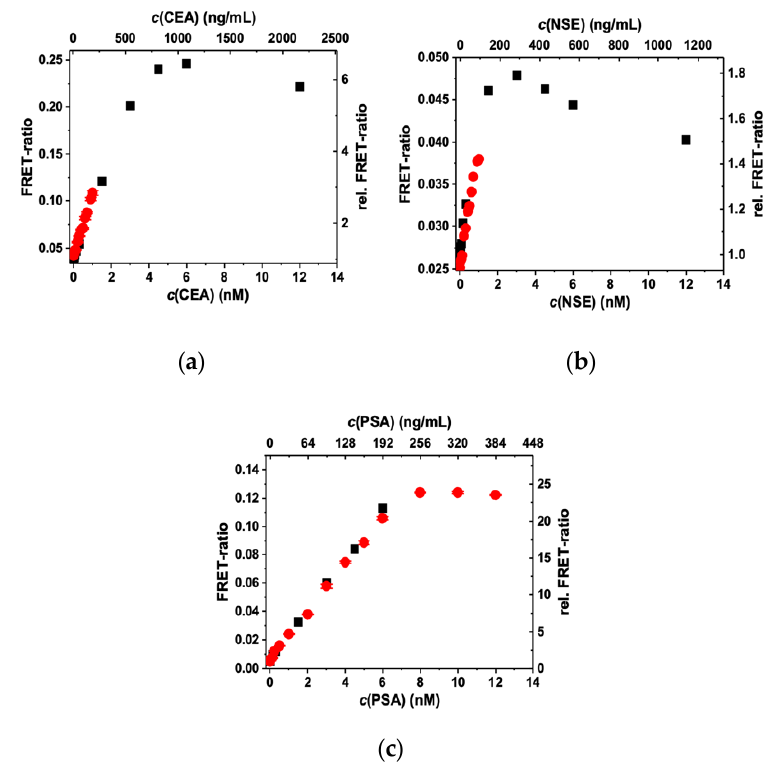
Figure 4. FRET ratios and relative FRET ratios (normalized to unity at 0 nM antigen concentration) of TG QD and Tb PL intensities (0.1 to 0.9 ms after pulsed excitation) as a function of antigen concentration. ( a ) Tb–eQD650 FRET pair for the detection of CEA; ( b ) Tb–eQD605 FRET pair for the detection of NSE; and ( c ) Tb–iQD705 FRET pair for the detection of PSA. The red data points contain more measurements at low concentrations and were used for the determination of limits of detection (LoDs) (cf. Table 2). Only the linear part of the red data points in ( c ) was used for LOD calculation. Table 2. Förster distances and LoDs for the single tumor marker (CEA, NSE, and PSA) FRET immunoassays.